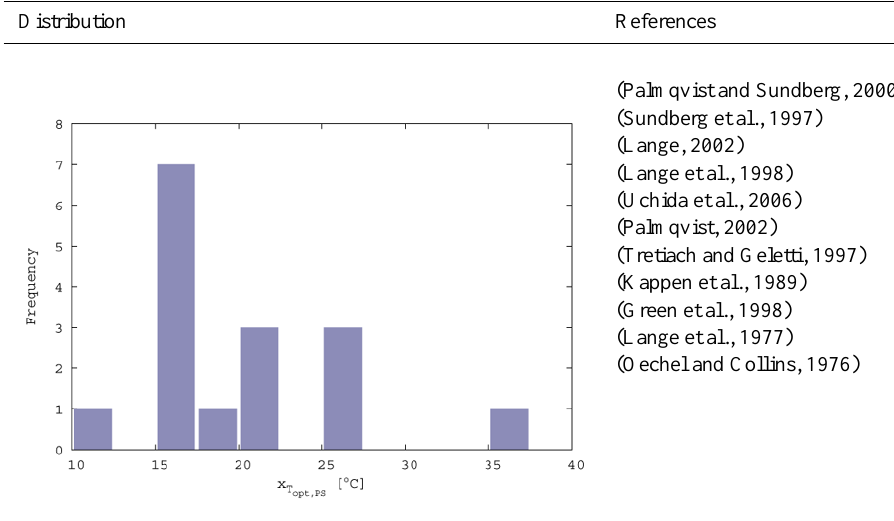
Fig. B9. Overview of the distribution of the optimum temperature of photosynthesis x T